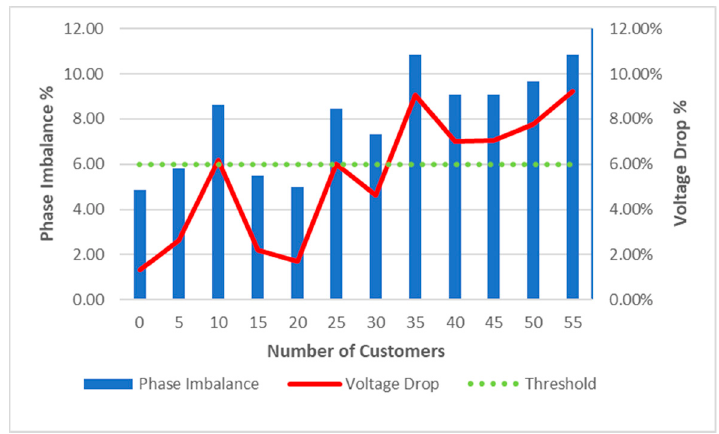
Figure 5. Phase imbalance and voltage deviation percentages for the different number of customers.